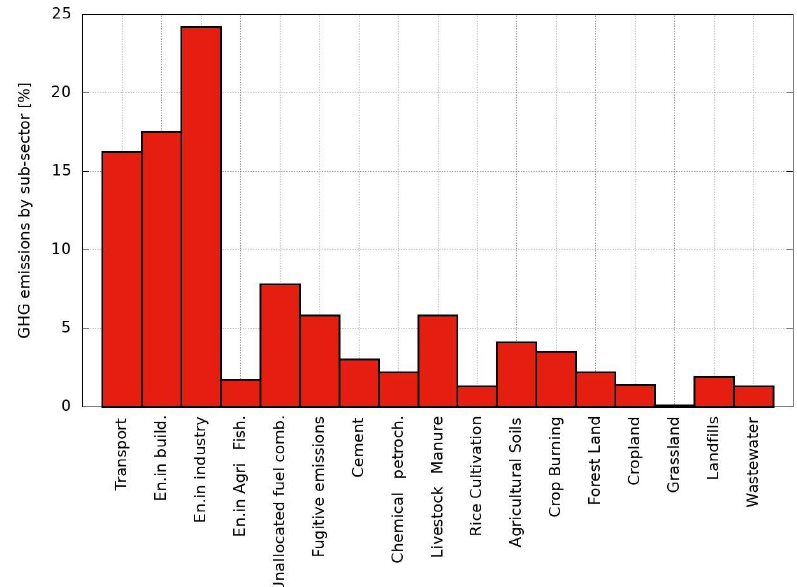
Figure 1. GHG emissions by sub-sector percentage (Data source [1]).